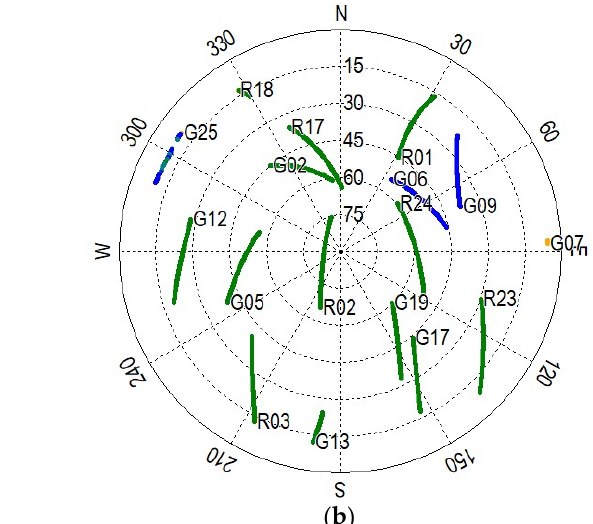
Figure 7. Positioning errors of GPS + GLONASS and GPS + GLONASS/UWB solutions. In this paper, the convergence criterion is defined as follows: the absolute value of the positioning errors is less than 0.1 m and remains within 0.1 m in the subsequent 300 epochs. The positioning errors of the three components after convergence are used for statistical RMS values. Table 1 summarizes the RMS values of the positioning errors with respect to GNSS/UWB and GNSS-only solutions. The results show that the RMS values of the GPS/UWB integration are 2.48 cm, 1.67 cm and 6.02 cm with an improvement of 4.46 cm, 5.98 cm and 5.20 cm in the north, east and up components, compared to that of the GPS-only solution. Besides, compared to the RMS values of positioning errors for the GPS + GLONASS solution, the RMS values of positioning errors for GPS + GLONASS/UWB integration show an improvement of about 2.72 cm, 1.68 cm and 2.23 cm in the north, east and up components. Regardless of whether GNSS-only solutions or GNSS/UWB solutions are used, all of them can achieve a centimeter-level positioning accuracy in horizontal di- rections after convergence. Additionally, the GNSS/UWB tightly coupled integration holds higher positioning accuracy. The RMS improvement percentages of the GNSS/UWB